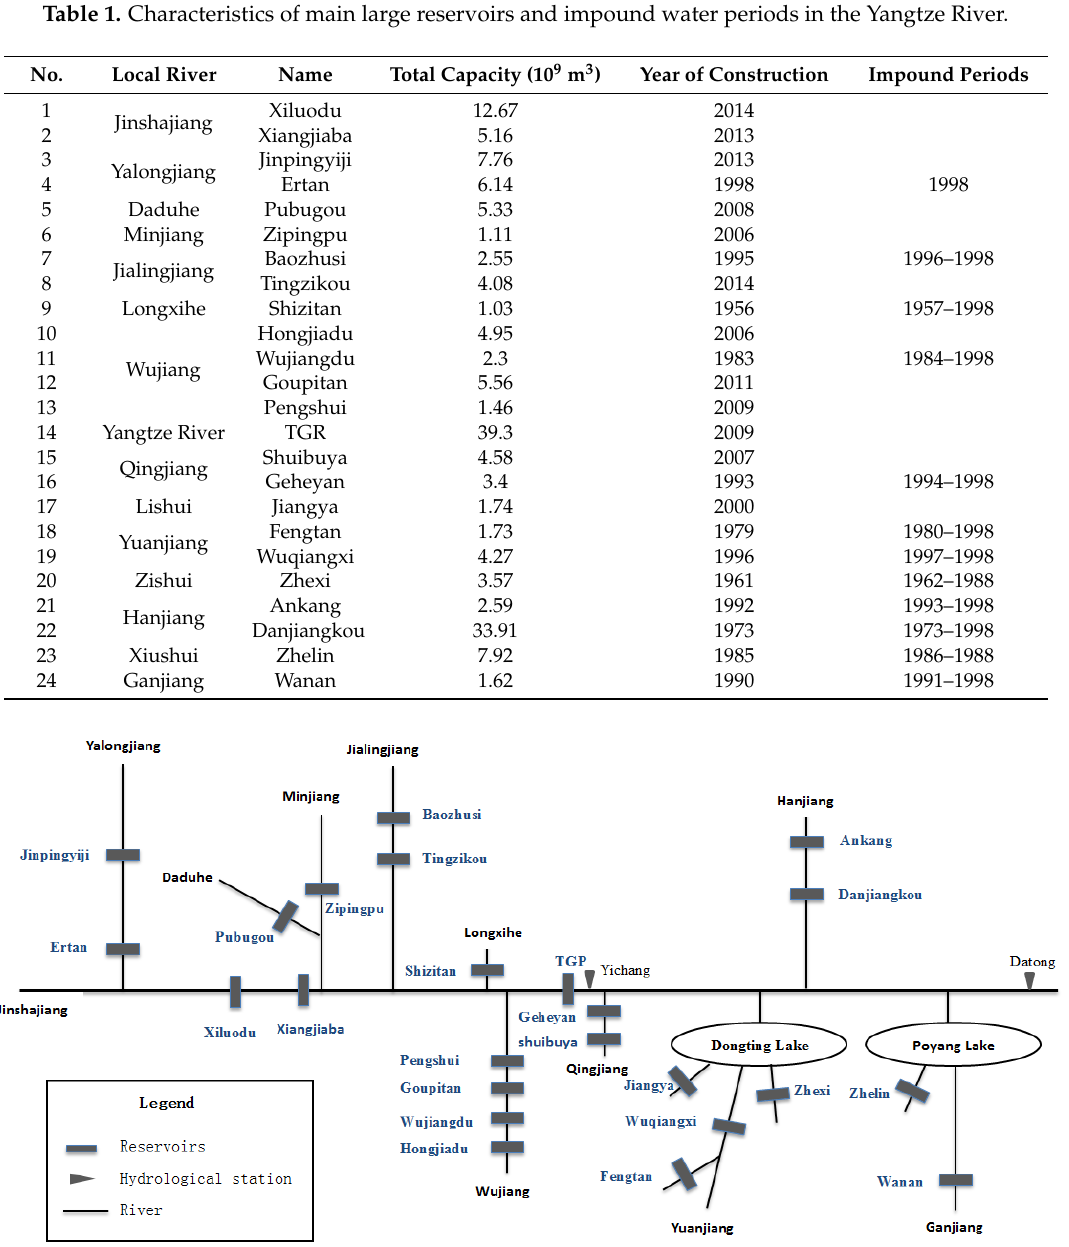
Figure 2. A sketch map of the main large reservoirs in the Yangtze River basin.